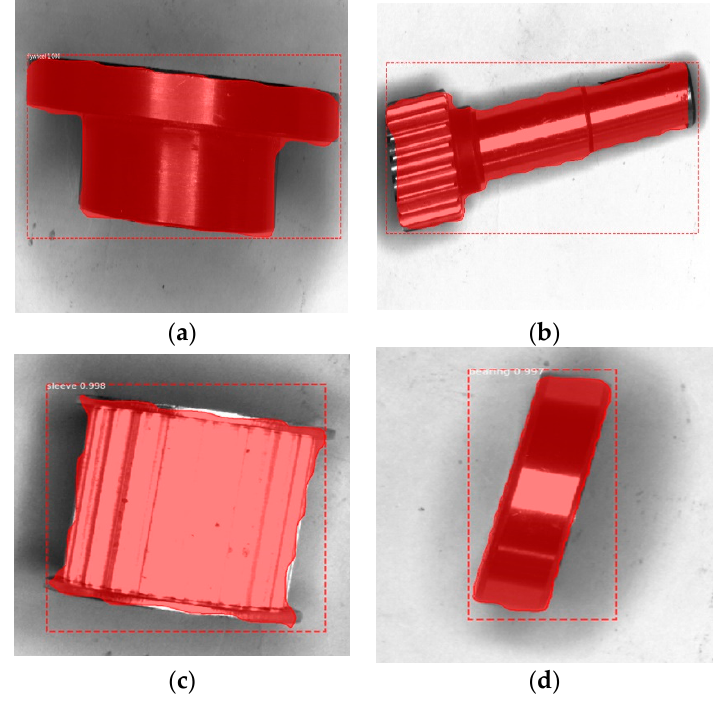
Figure 14. Multi-category test result.